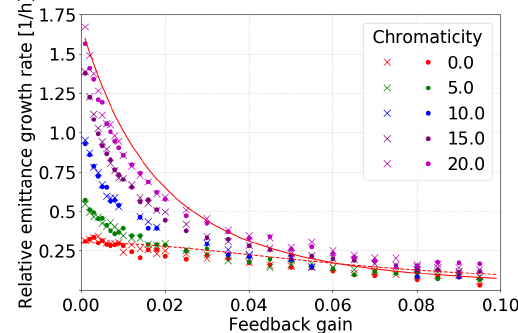
FIG. 4. Relative emittance growth rate as a function of the feedback gain for different chromaticities, for a symmetric con- figuration with a single interaction point. The numerical param- eters for the simulations are listed in Table I. The crosses and dots correspond to the horizontal and vertical planes respectively. The solid and dashed red line correspond to the weak-strong and strong-strong model predictions without